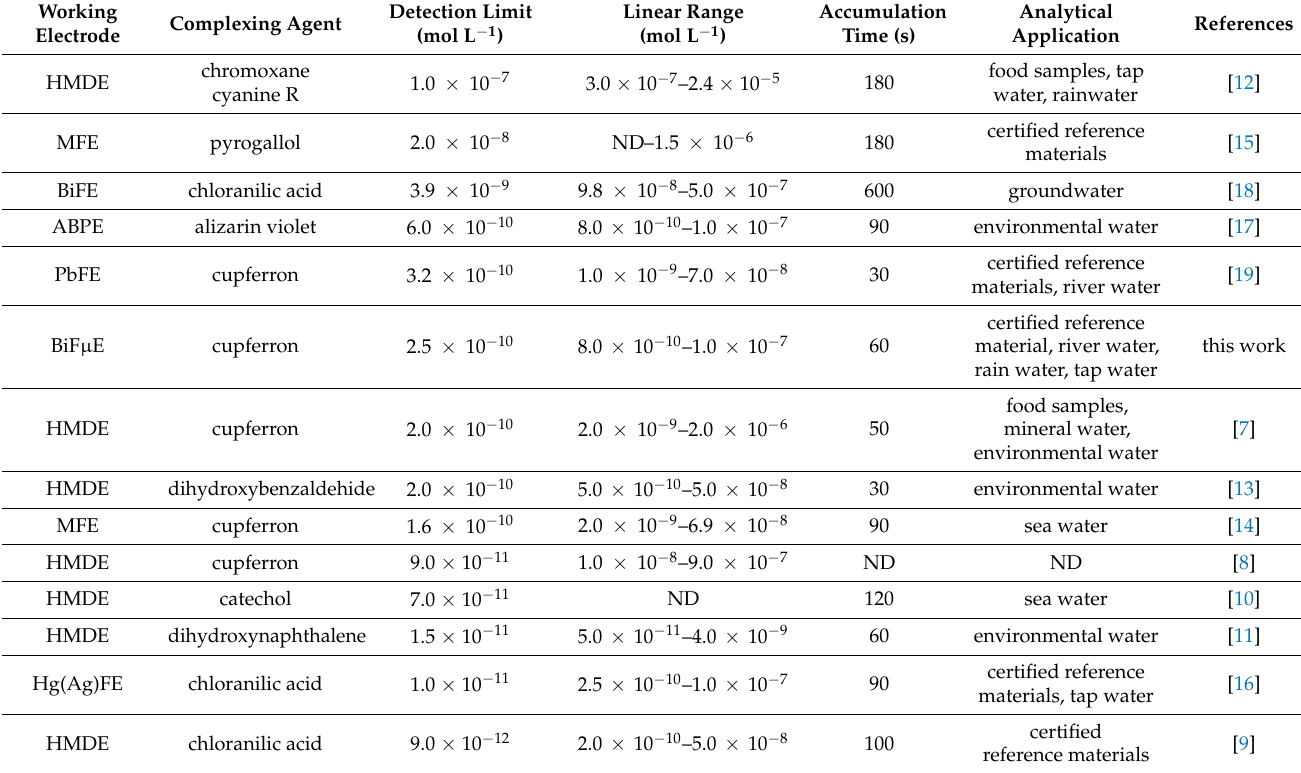
Table 1. The comparison of the analytical parameters of the proposed procedure with the other AdSV procedures developed to